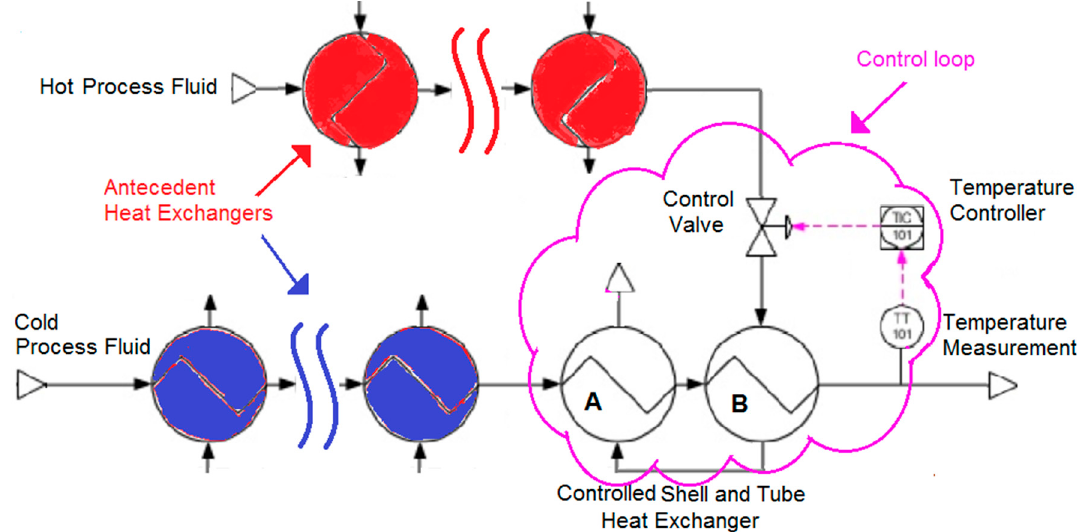
Figure 18. Schematic diagram of a PID-controlled HE with the antecedent HEs.